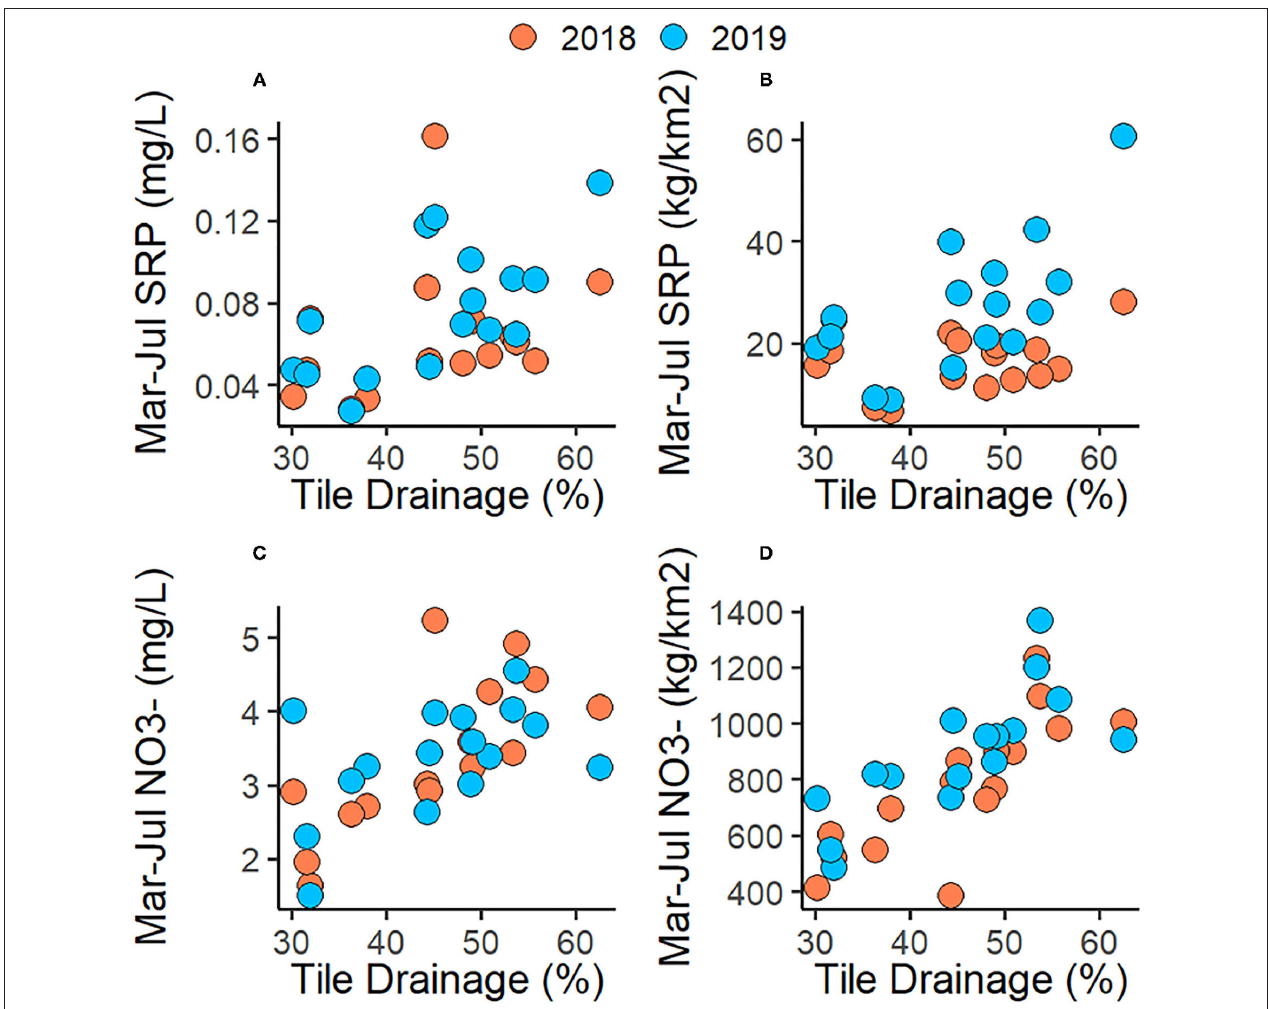
FIGURE 4 | March–July SRP concentration ( A ; Pearson’s r = 0.30 and 0.64, respectively) and load ( B ; Pearson’s r = 0.23 and 0.66, respectively) vs. tile drainage during 2018 and 2019. March–July nitrate (NO − 3 ) concentration ( C ; Pearson’s r = 0.74 and 0.50, respectively) and load ( D ; Pearson’s r = 0.80 and 0.76, respectively) vs. tile drainage during 2018 and 2019.